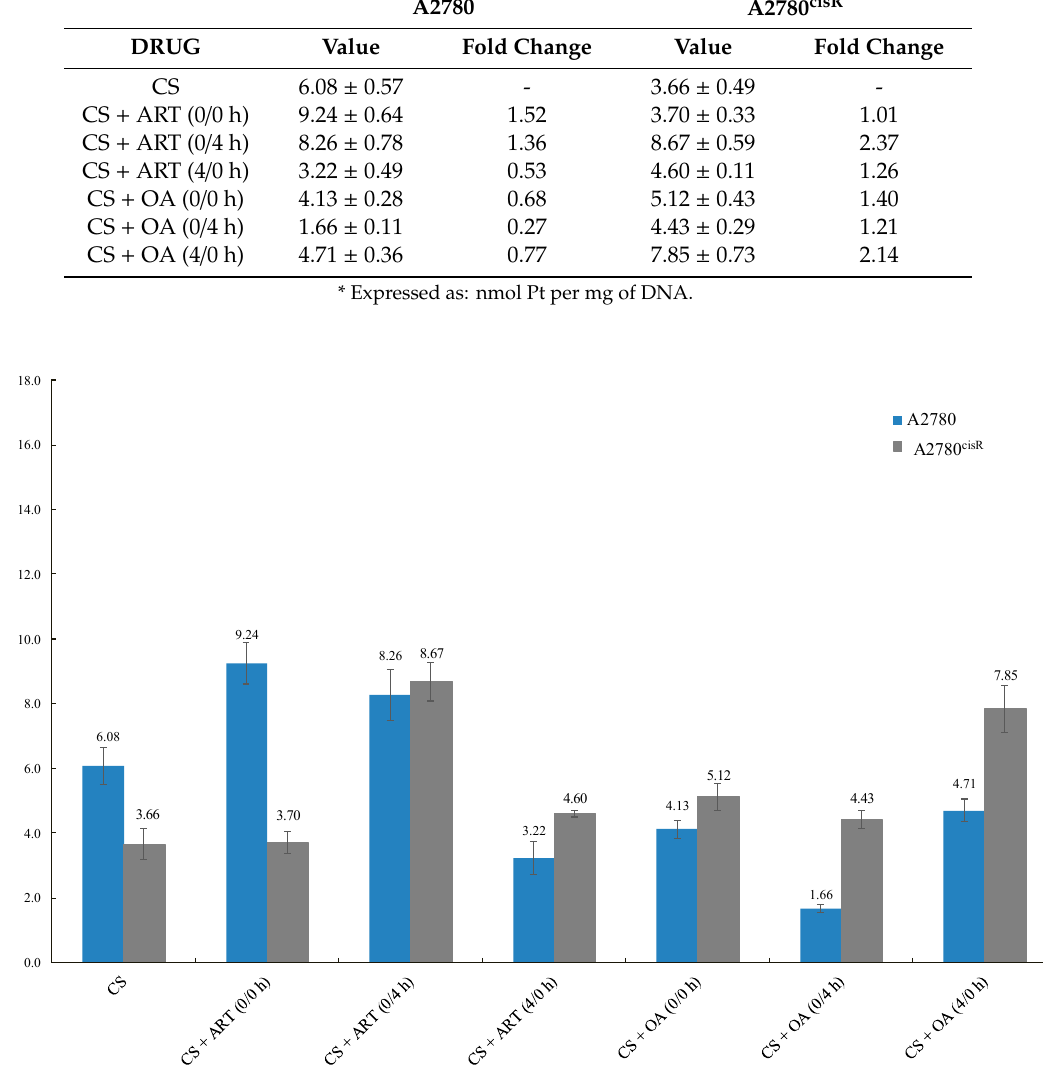
Table 6. Platinum–DNA-binding levels of CS alone and in combinations with ART and OA. * Platinum–DNA Binding Level